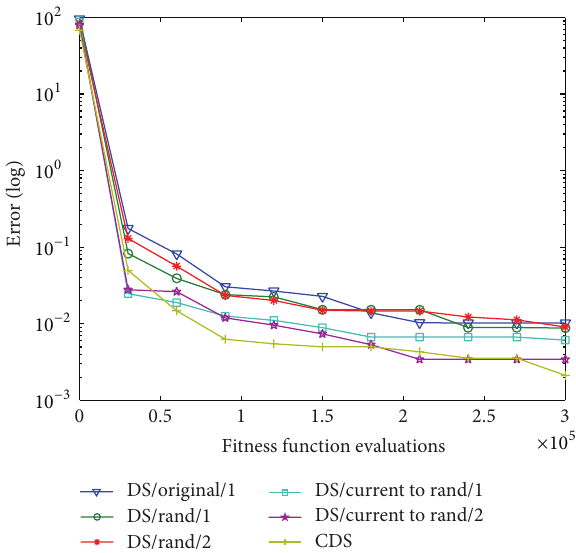
Figure 4: Comparison of performance of six algorithms for mini- mization of 𝑓 04 with dimension 30.